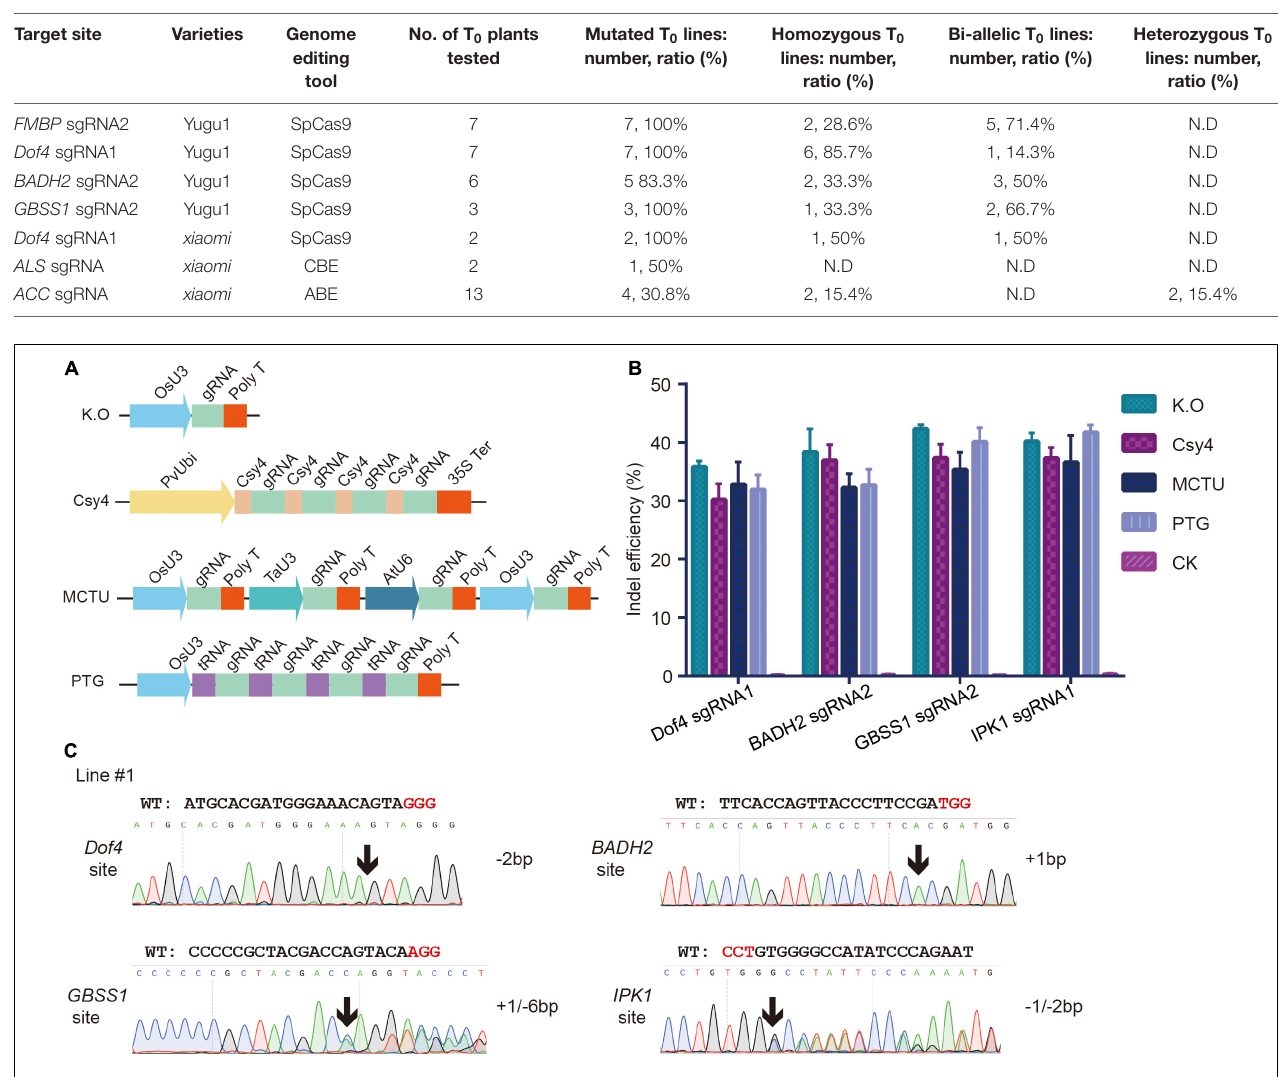
TABLE 1 | Summary of T 0 plant characterization.